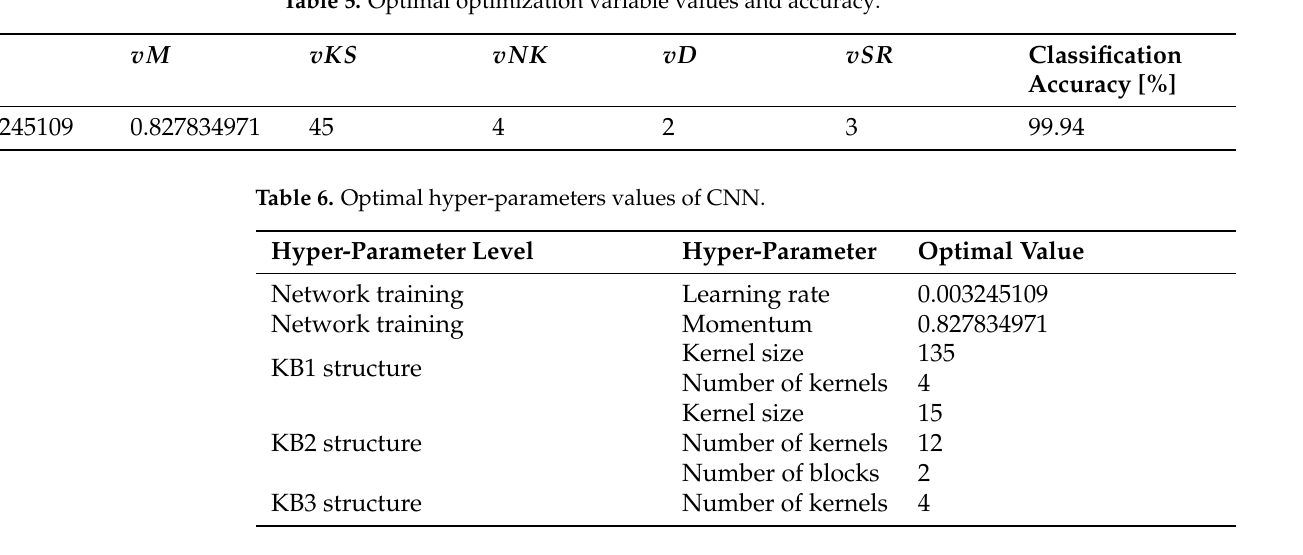
Table 5. Optimal optimization variable values and accuracy.